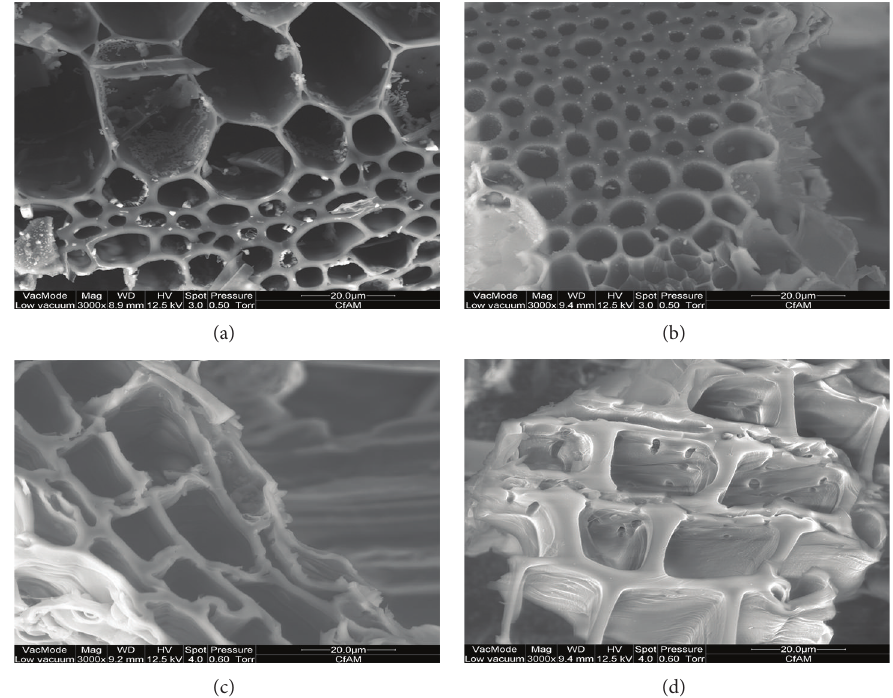
Figure 1: Environmental scanning electron microscope (FEI Quanta FEG 600) images of (a)-(b) barley straw biochar and, (c)-(d) pine wood shaving biochar. Images are 3000x magnification and were obtained at 12.5kV and low vacuum (0.50 and 0.60 Torr for straw and pine wood biochars, resp.).